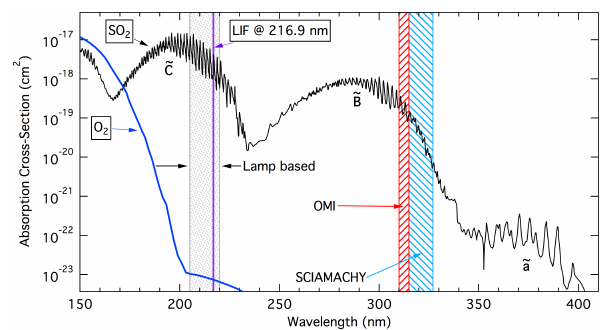
Figure 1. SO 2 absorption spectrum compiled by Manatt and Lane (1993). The approximate region used in lamp-based SO 2 flu- orescence instrumentation (205–220nm) is indicated by the shaded gray region, and the 216.9 used in this work indicated by the solid violet line. Spectral regions used by OMI (Ozone Monitoring In- strument) and SCIAMACHY (Scanning Imaging Absorption Spec- trometer for Atmospheric Cartography) satellite instruments for column SO 2 retrievals are indicated. Bands corresponding to exci- tations into the first three electronic excitations of SO 2 are indicated by ã, e B, and e